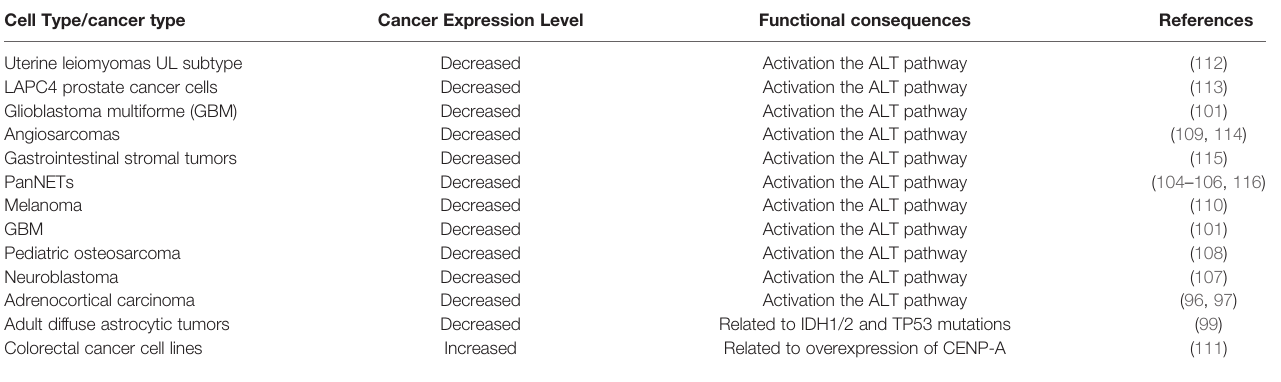
TABLE 3 | Expression and mechanism of ATRX in